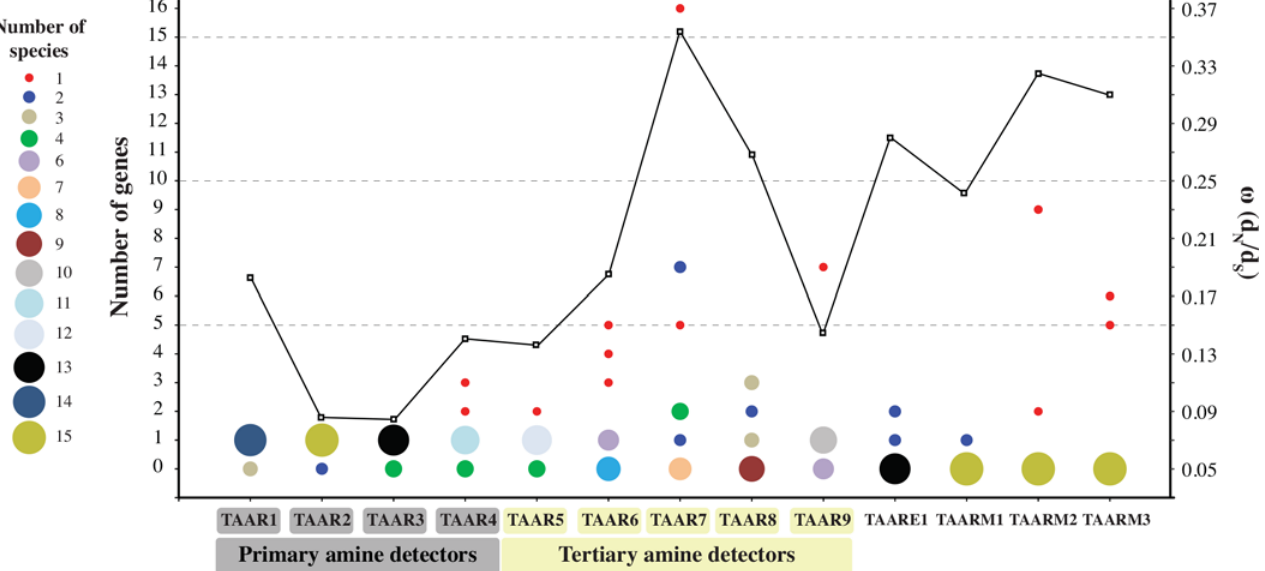
Fig 4. The number of TAAR genes within each TAAR subfamily for each therian species. The size of bubbles denotes the number of species where the corresponding TAAR genes are found. The average ω (dN/dS) calculated by the PAML M0 model for each TAAR subfamily is also plotted (open squares).